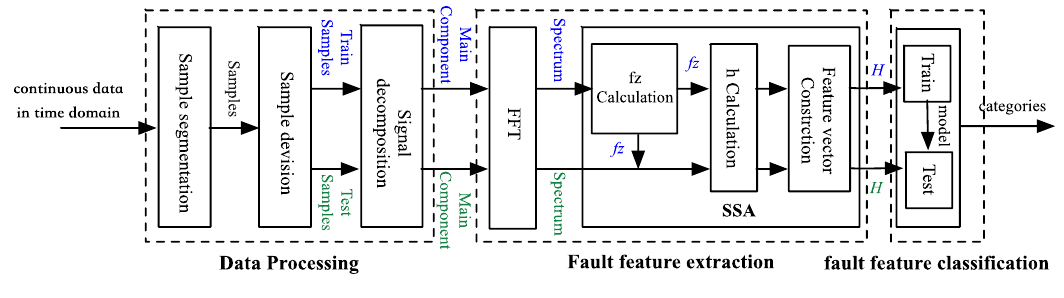
Figure 2. SSA-based diagnostic framework.